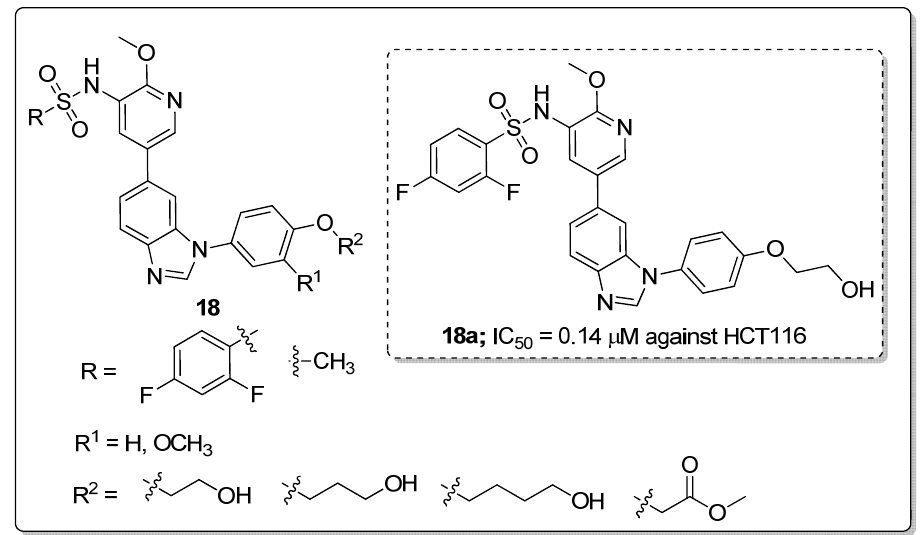
Figure 21. Antiproliferative activity of the most active benzo[ d ]imidazole conjugate 18a .